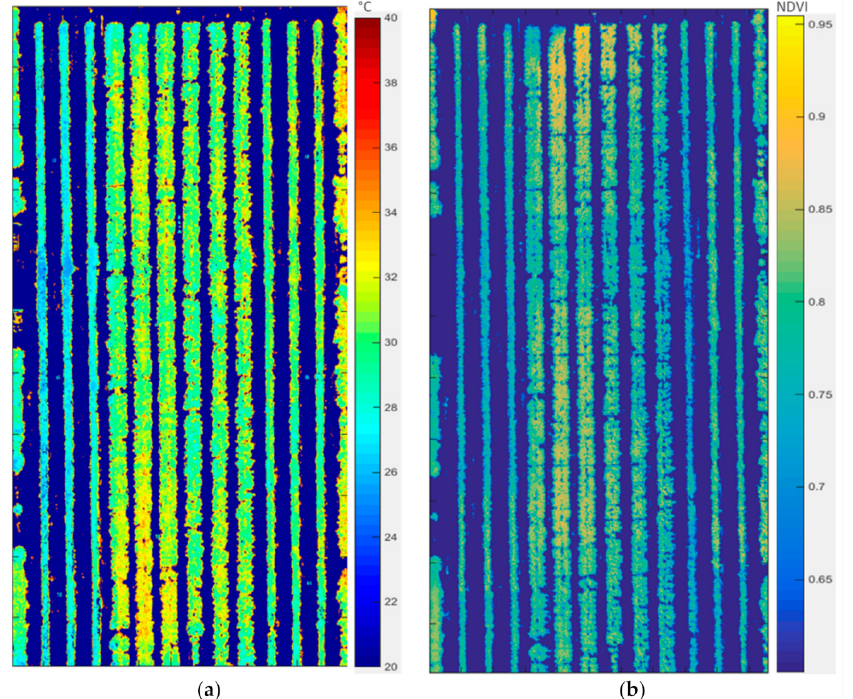
Figure 5. Tree-row map excluding soil background using tge histogram-based method: ( a ) surface temperature map ( ◦ C); ( b ) NDVI map.